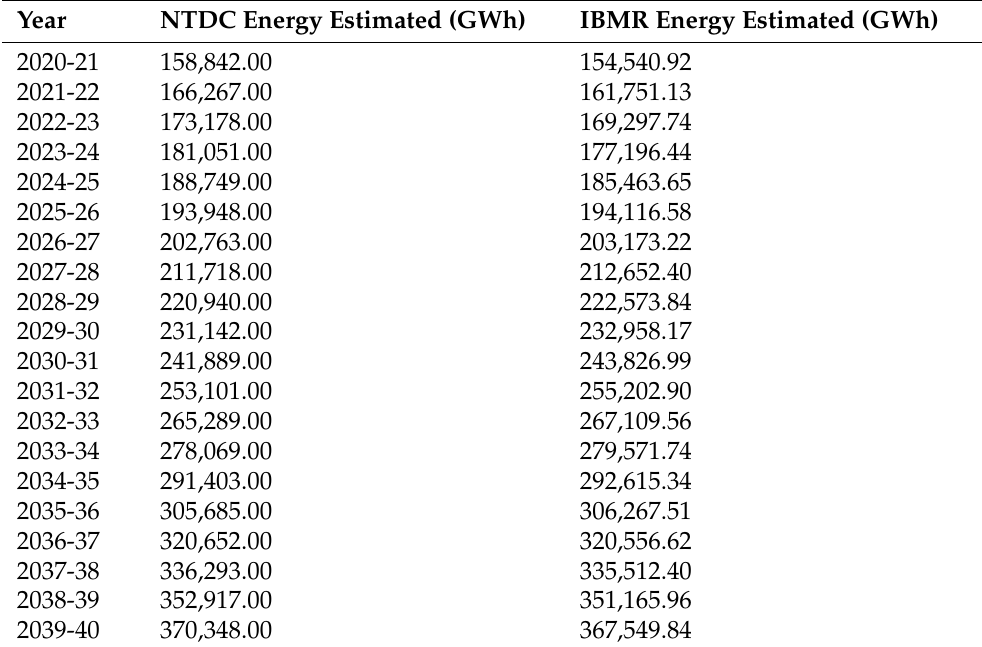
Table 6. Indicative Generation Plan for the year